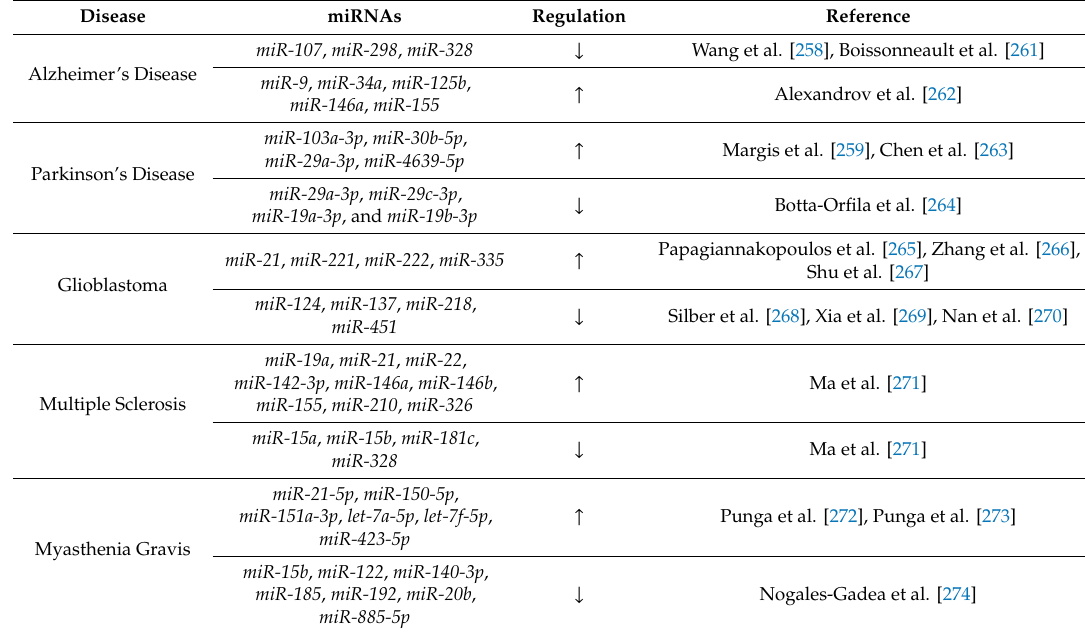
Table 4. miRNA regulation in neurologic